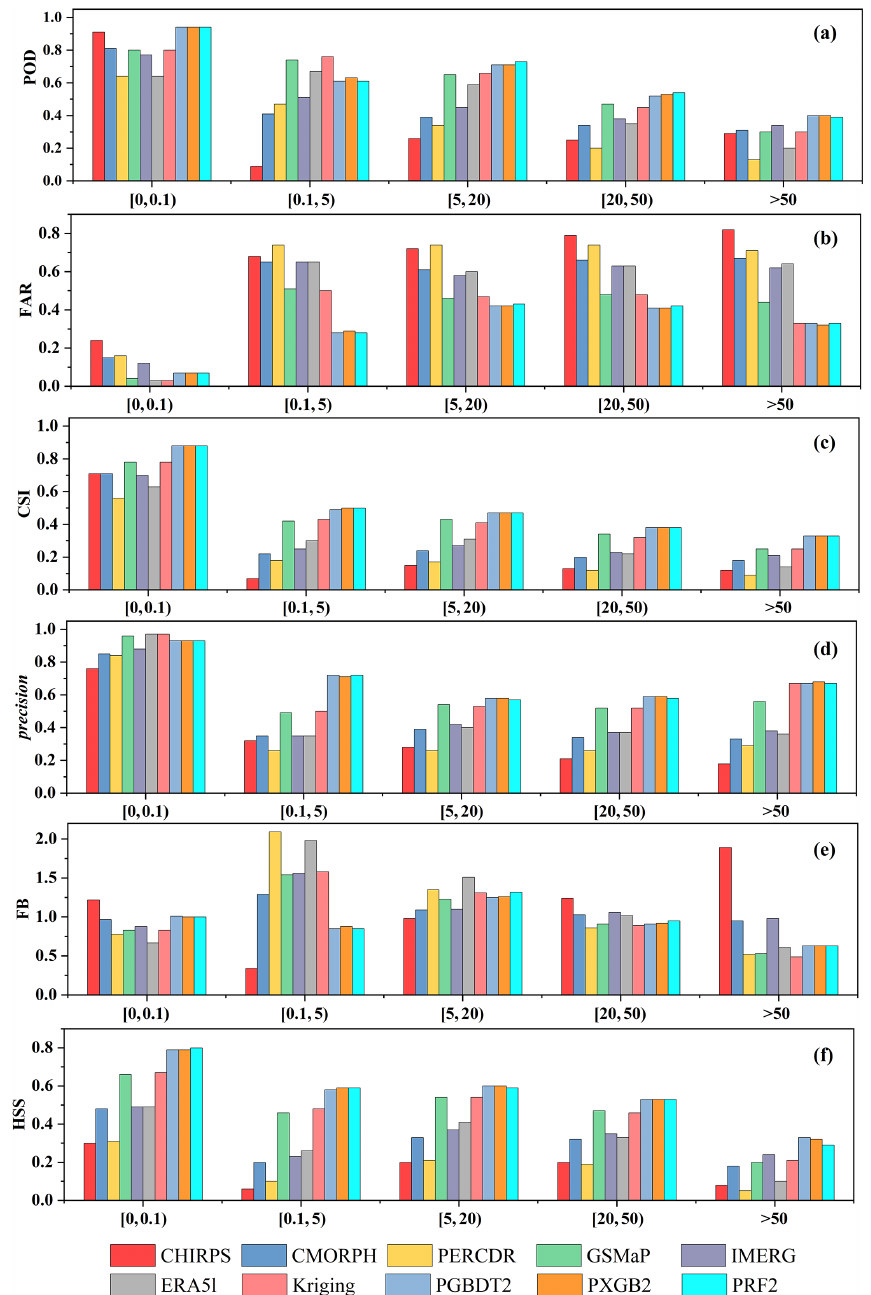
Figure 6. The performance of six categorical metrics (POD (a) , FAR (b) , CSI (c) , precision (d) , FB (e) , and HSS (f) ) of 10 products under various daily precipitation